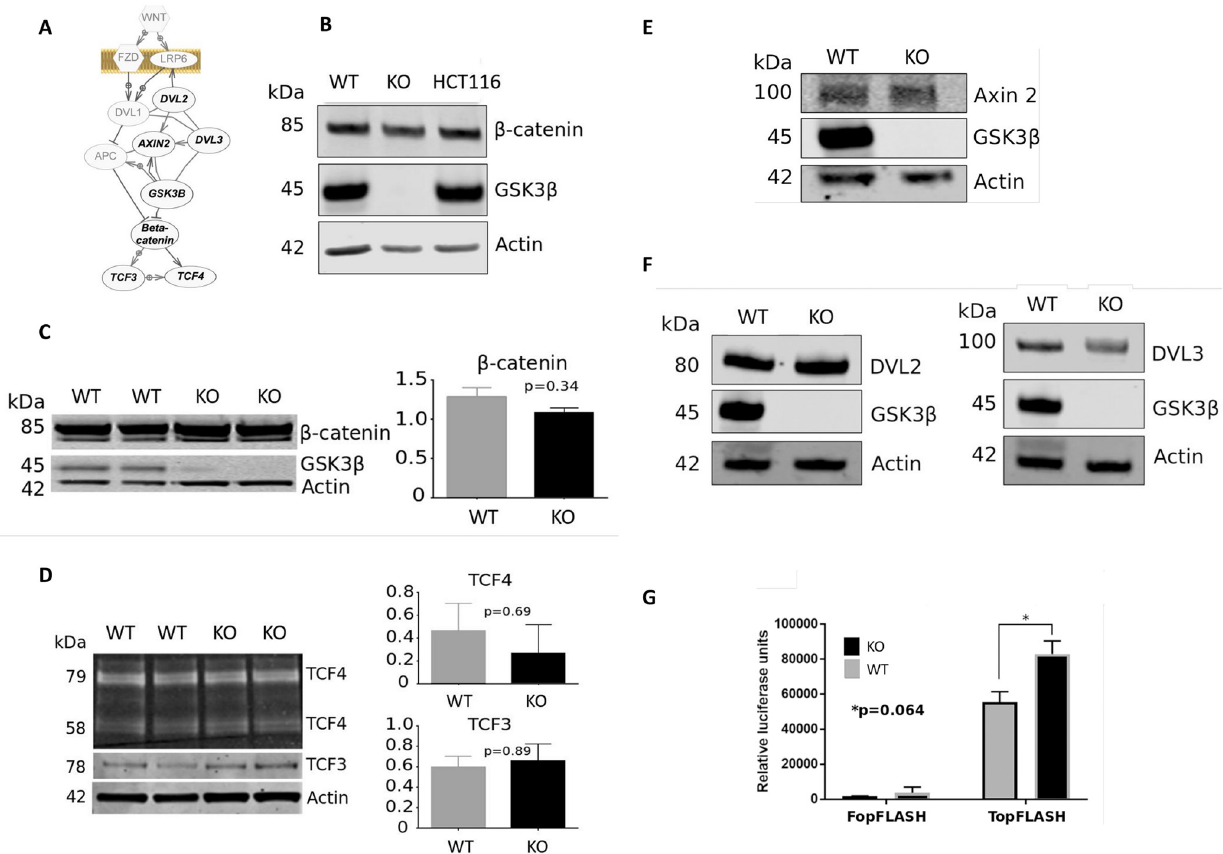
Fig 2. ( A ) Schematic of the canonical Wnt signalling pathway and summary of key proteins analysed in this study. Proteins identified in the mass- spectrometry study are shown, those not analysed by Western blot are shown in grey. Western blot analysis of canonical Wnt components and GSK3 β protein expression characterization in cell models. 15 μ g of total protein lysates from each cell-line were analyzed on a single phase 8% SDS gel and alpha- actin used as loading control. All were replicated in at least n = 3 unless indicated otherwise. Quantifications (arbitrary intensity units) are mean values ± SEM (Mann-Whitney U test p-value indicated). ( B ) Protein expression of GSK3 β and β -catenin in HCT116 cells (independently sourced isolate), HCT116-GSK3 β -KO cells and HCT116-GSK3 β -WT cells. ( C ) β -catenin, ( D ) TCF3 and TCF4, ( E ) Axin 2, ( F ) DVL2 and DVL3 (n = 2). All Westerns are representative examples, and quantifications are expressed as arbitrary intensity units. ( G ) TopFLASH reporter assay of canonical Wnt signalling activity in HCT116-GSK3 β -WT and HCT116-GSK3 β -KO cells. Cells were transfected with TopFLASH plasmids, TopFLASH luciferase activity was assessed 48 hours post-transfection following passive lysis of cells. Luciferase signaling was normalized to Renilla transfection control. p-value 0.064, n = 3.